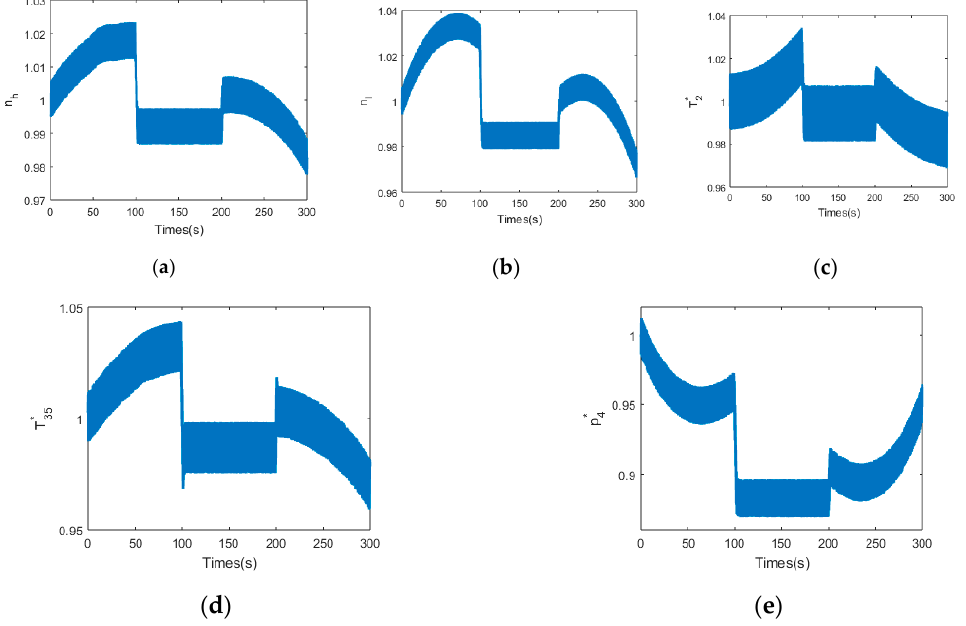
Figure 4. Profiles of ( a ) the high pressure turbine rotor speed 𝑛 (cid:3035) , ( b ) fan rotor speed 𝑛 (cid:3039) , ( c ) the low pressure compressor outlet total temperature 𝑇 (cid:2870)∗ , ( d ) the high pressure turbine outlet total temperature 𝑇 (cid:2871)(cid:2873)∗ and ( e ) the low pressure turbine outlet total pressure 𝑝 (cid:2872)∗ . The state equations and measurement equations for SRCKF are provided by the CEME model.